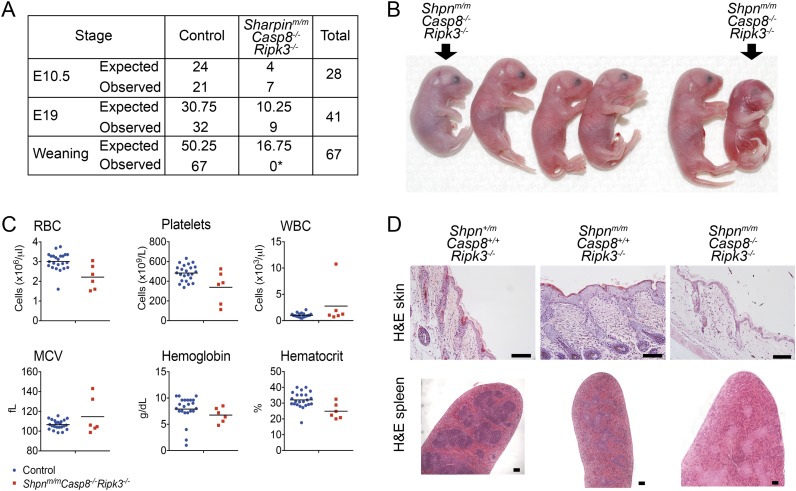
Shpnm/mCasp8−/−Ripk3−/− mice are prone to perinatal lethality.(A) Table of segregation of expected and observed genotypes from Shpn+/mCasp8-/-Ripk3−/− or Shpnm/mCasp8+/-Ripk3−/− intercrosses at various developmental stages. E10.5 controls: Shpn+/+
or
+/mCasp8-/-Ripk3−/−; E19 controls: Shpnm/mCasp8+/+
or
+/−Ripk3−/−; weaning controls: Shpn+/+
or
+/mCasp8−/−Ripk3−/− or Shpnm/mCasp8+/+
or
+/−Ripk3−/−. *Significantly different to expected value, Fisher's exact test p < 0.0005. (B) Photos of E19 embryos obtained by Caesarian section. The Shpnm/mCasp8−/−Ripk3−/− mouse on the right was recovered dead, all others were alive. Other embryos are control mice: Shpnm/mCasp8+/+ or +/−Ripk3−/−. (C) ADVIA blood analysis from E19 embryos. RBC: red blood cells; WBC: white blood cells; MCV: mean cell volume. Horizontal lines depict data means. Control mice: Shpnm/mCasp8+/+ or +/−Ripk3−/−. (D) Histological analysis of tissue from 12-week-old mice of indicated genotypes. Mice were from a separate facility to those in A–C and are not included in the table in A. Two mice were analyzed for each genotype. Scale bars: skin 100 µm, spleen 50 µm.